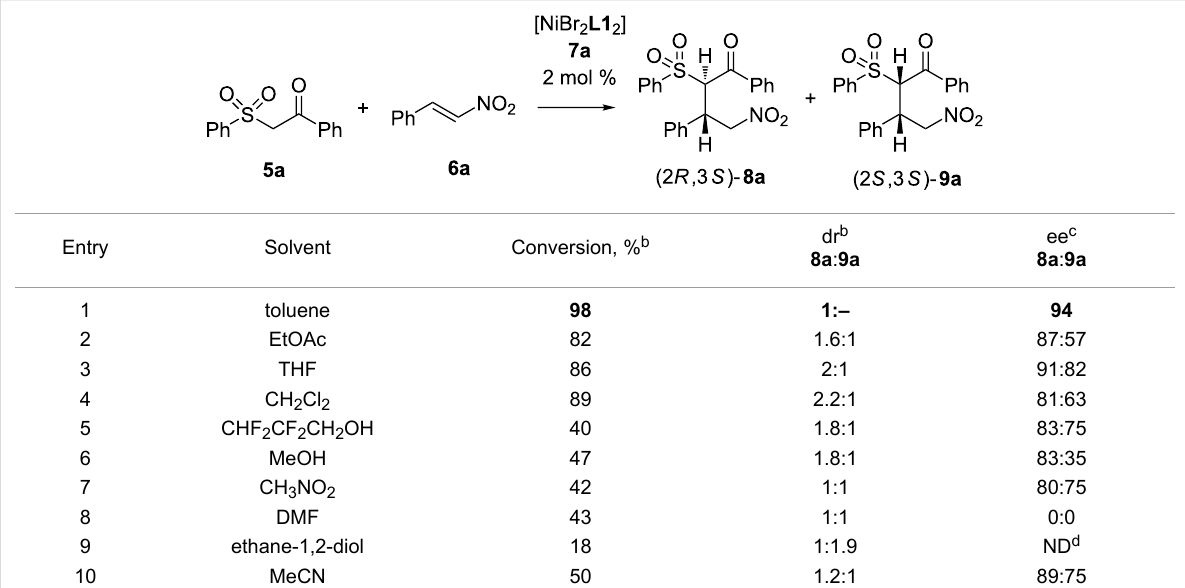
Table 2: Solvent effect on the reaction of 1-phenyl-2-(phenylsulfonyl)ethan-1-one ( 5a ) with ω -nitrostyrene ( 6a ) a .